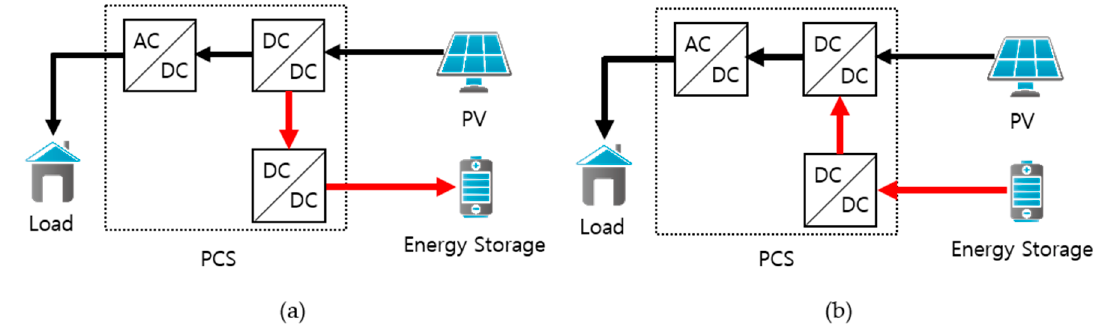
Figure 4. Energy flow of ESS with PV in island mode ( a ) charge mode ( b ) discharge mode.